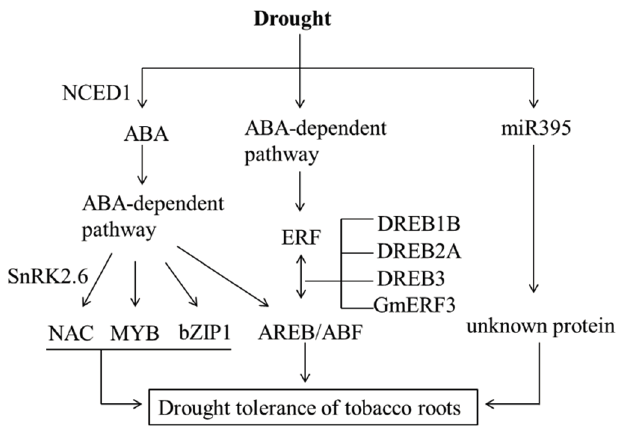
Figure 7. A probable model for regulatory network being involved in drought responses in tobacco roots. The integrated gene regulatory network has been proposed on basis of previous regulatory network model of Arabidopsis in the drought and cold stress